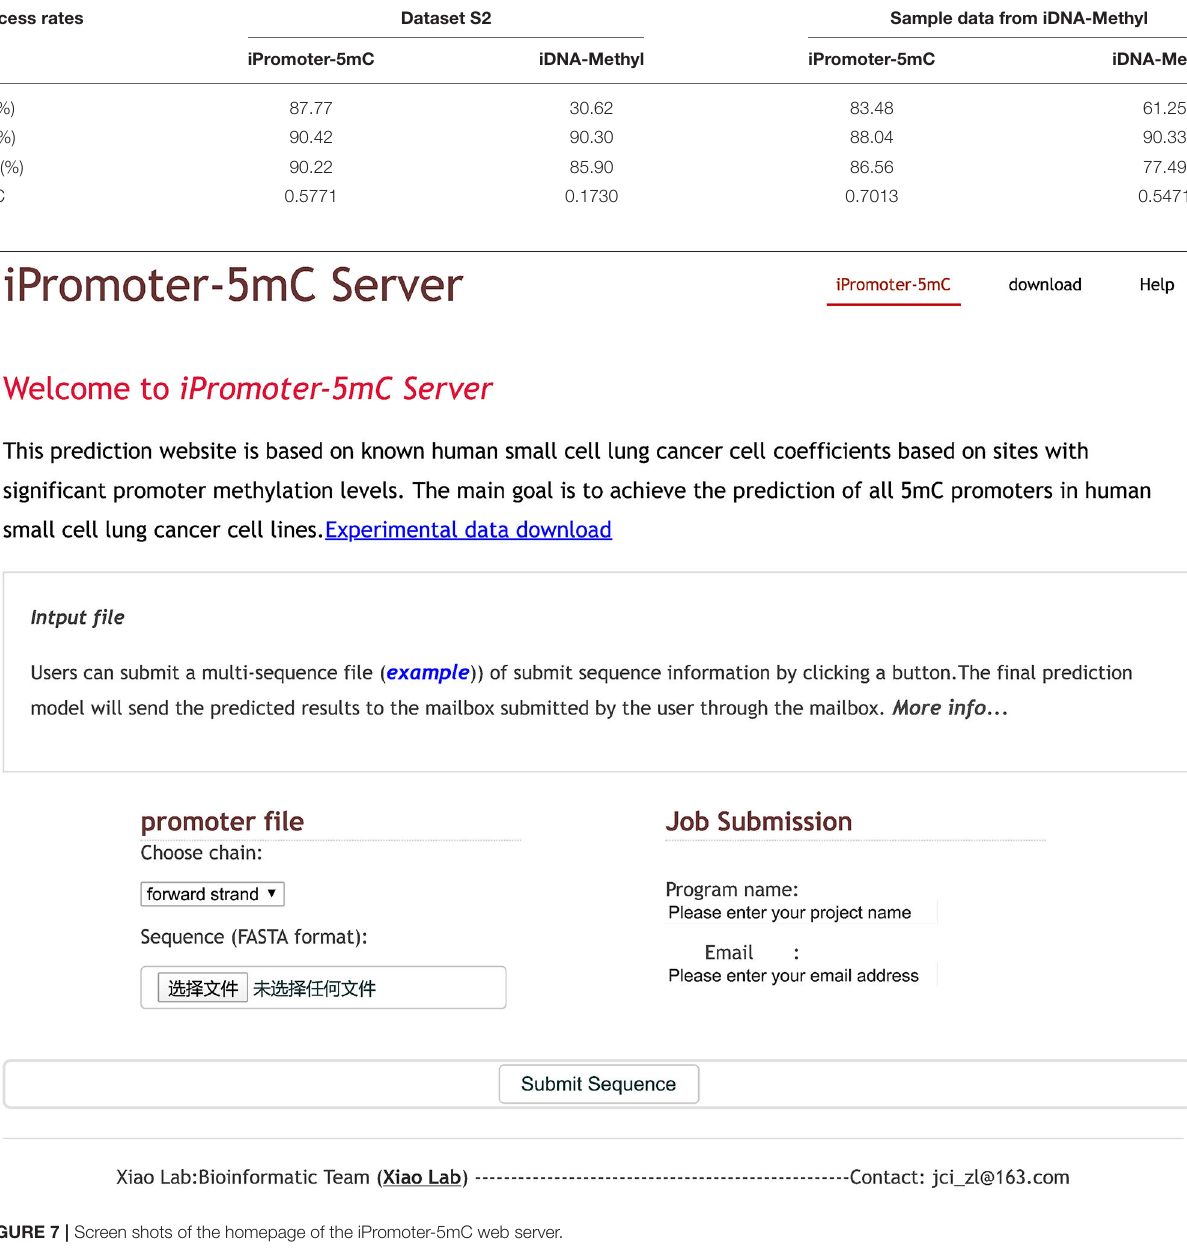
and negative samples from iDNA-Methyl is about 1:2,